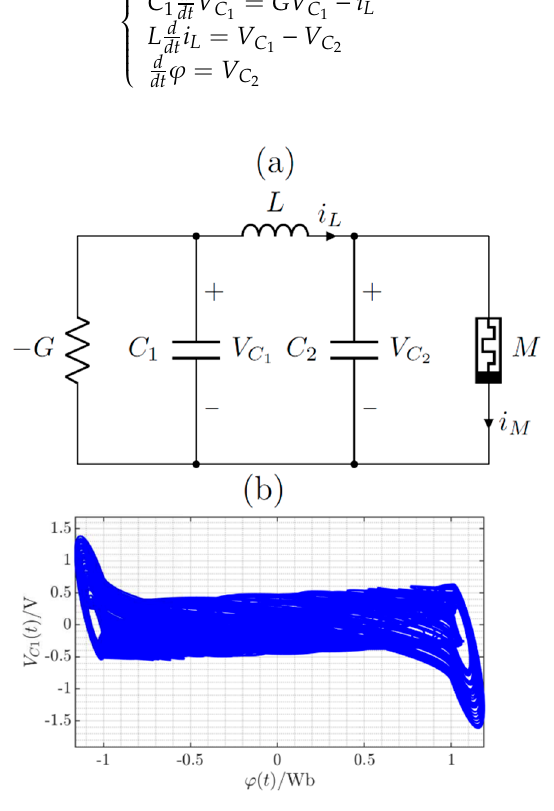
Figure 3. Chaotic circuit based on a memristor with a linear piecewise function: ( a ) electric circuit; ( b ) diagram of φ ( t ) versus Vc 1 ( t ) of the chaotic attractor.